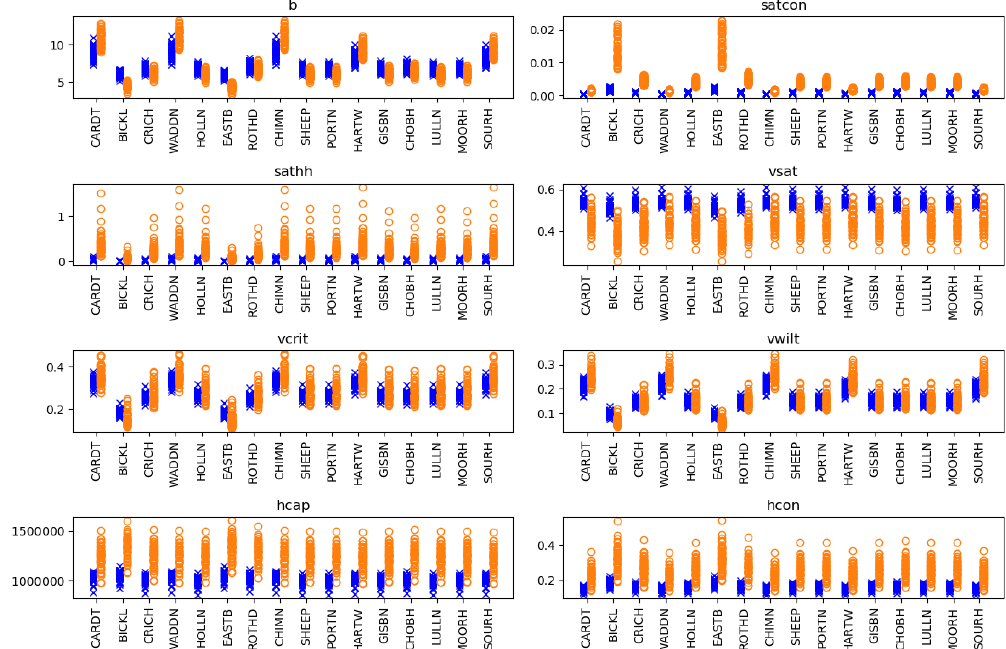
Figure 8. Ensemble prior (orange) and posterior (blue) parameter values at each site. These are topsoil results, which we have assumed to correspond to the top two soil layers in JULES (0–35cm depth from the